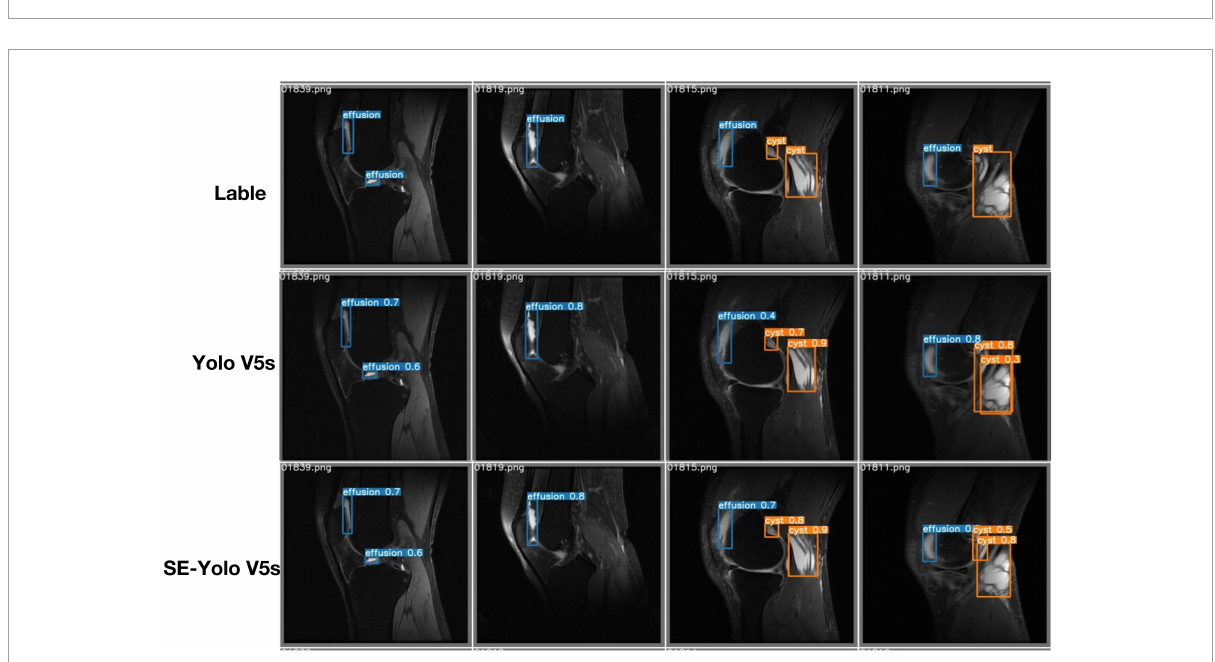
FIGURE7 Example prediction outcomes of YOLO V5 and YOLO V5-SE compared with the ground